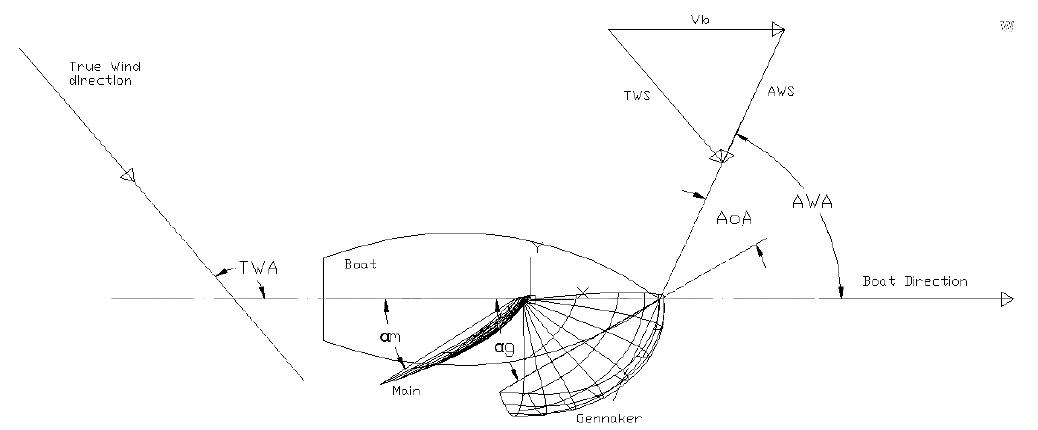
Figure 1. Main CFD parameters and sailing geometric variables.